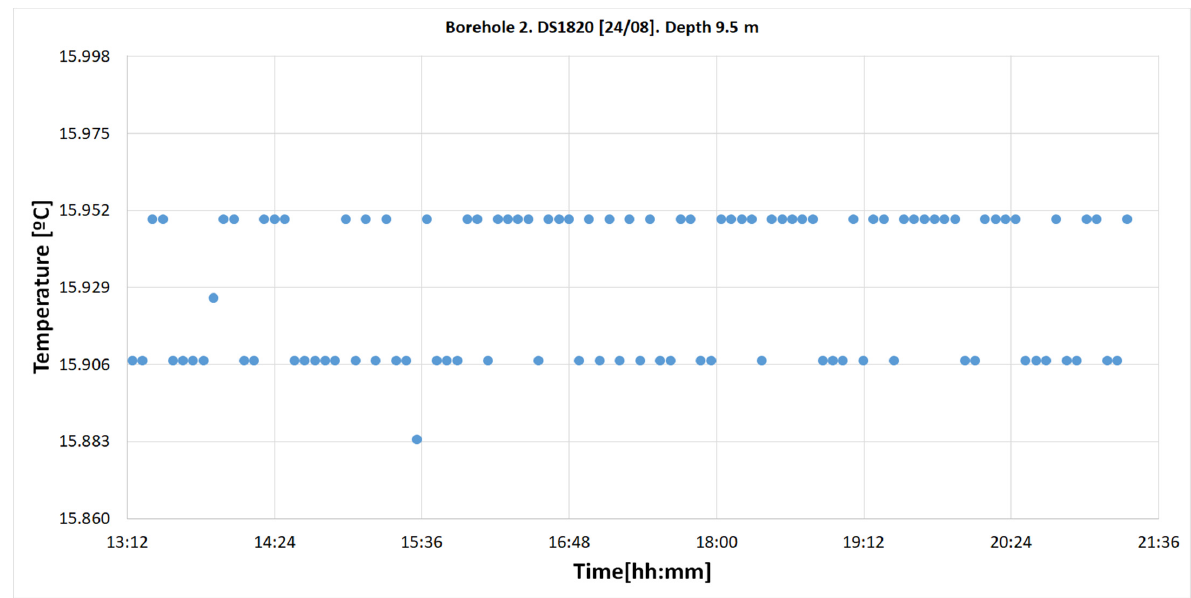
Figure 32. Temperature registers on 23 August in the “Q-Thermie-Uniovi-2” borehole with DS18B20 sensor at 9.5 m, obtained via interpolation.